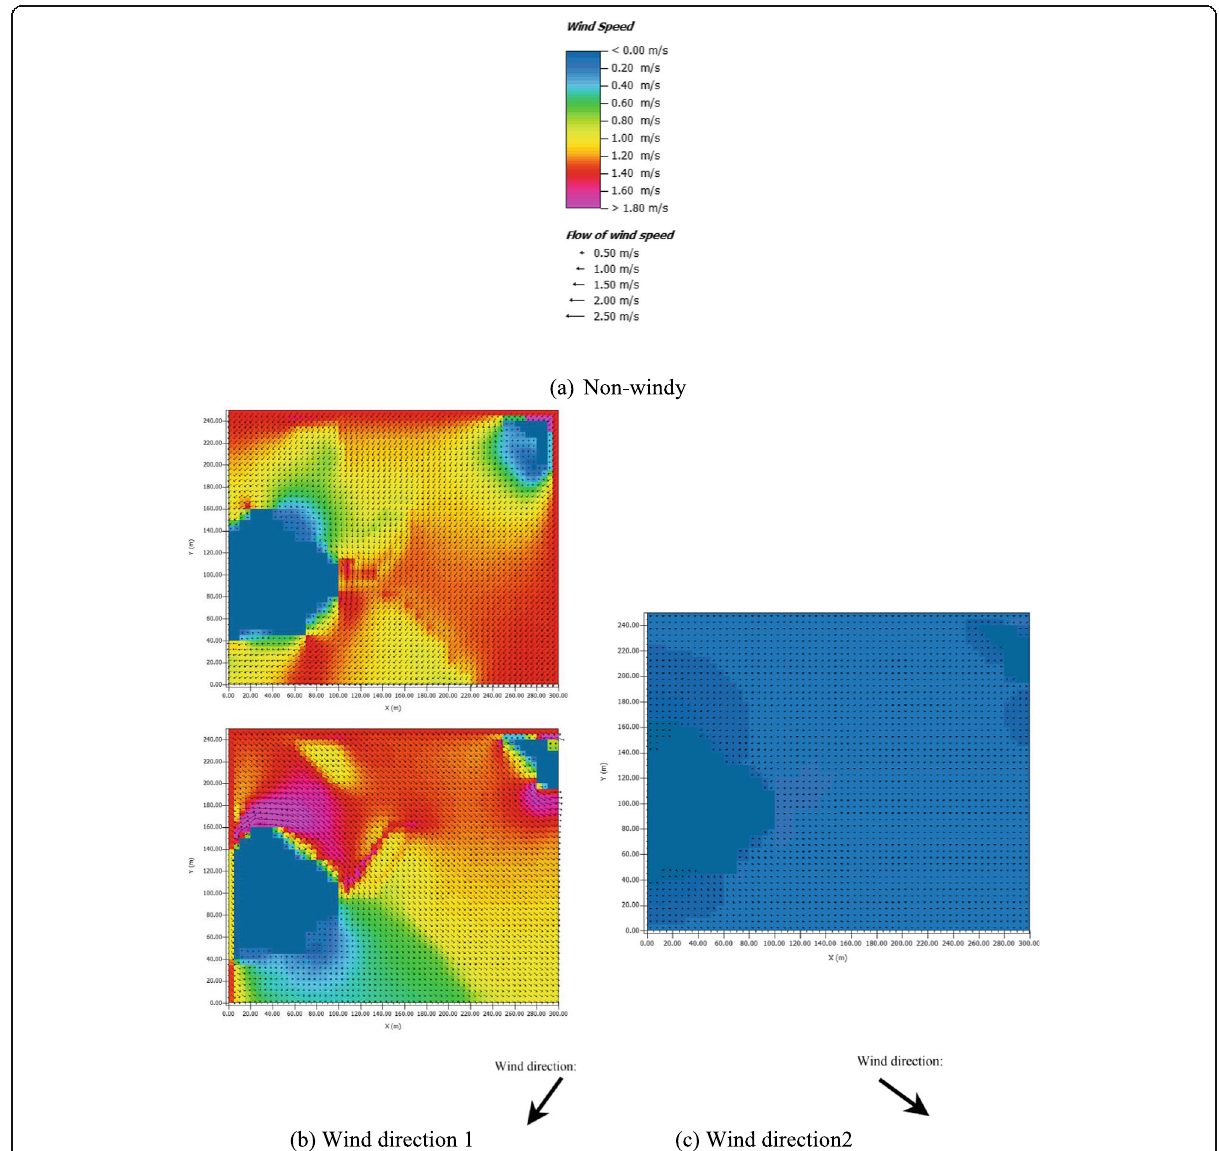
Fig. 5 The distributions of wind speed and direction in the simulation area under the three wind conditions